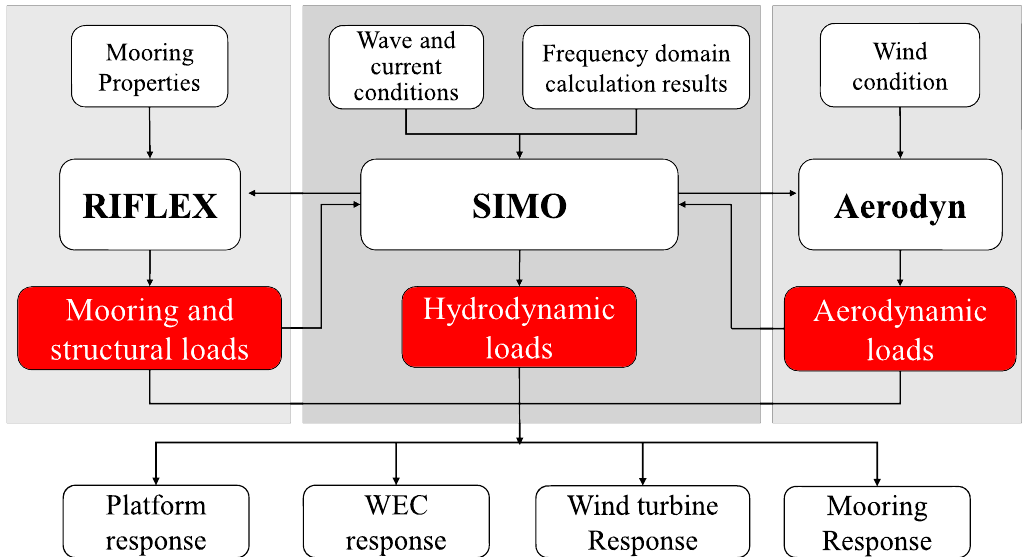
Figure 12. Schematic diagram of wind-wave coupling simulation flow through SIMO-RIFLEX-Aerodyn combined simulation.